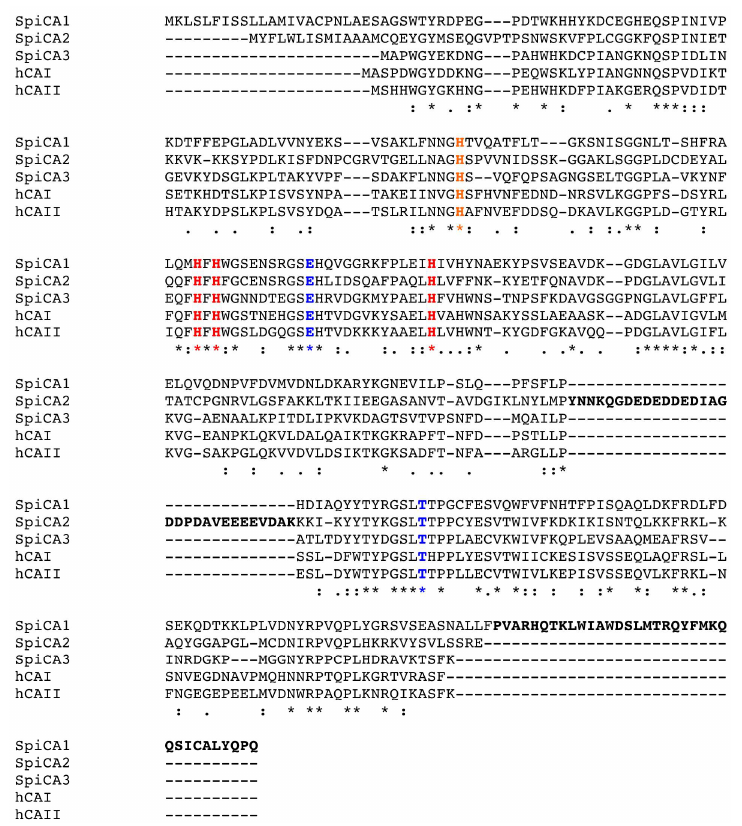
Figure 2. Multialignment of the α-CA amino acid sequences from human (hCAI and II) and S. pistillata (SpiCA1, SpiCA2 and SpiCA3). Multialignment was performed with the program Muscle. hCAI numbering system was used. Legend: zinc ligands, in red bold; “gate-keeper” residues, in blue bold; histidine proton shuttle, in orange bold; long stretches of 31 and 35 amino acid residues, in black bold; (*), indicates identity at a position; (:), designates conserved substitutions; (.) indicates semi-conserved substitutions; hCA I, Homo sapiens , isoform I (accession no. NP_001158302.1); hCA II, Homo sapiens , isoform II (accession no. AAH11949.1); SpiCA1, S. pistillata isoform 1 (accession no. ACA53457.1); SpiCA2, S. pistillata isoform 2 (accession no. EU532164.1); SpiCA3, S. pistillata isoform 3 (accession no. XP_022794253.1).